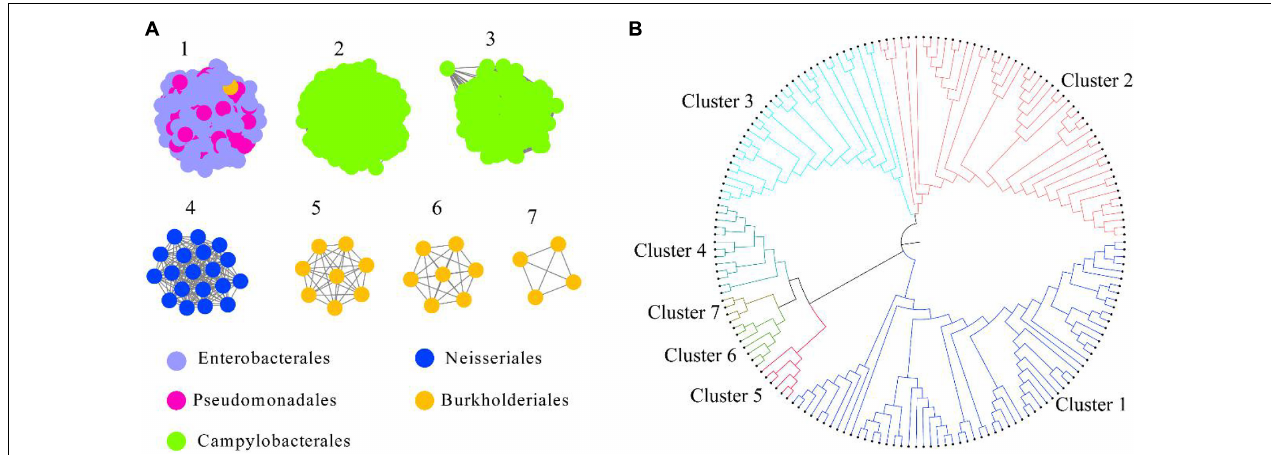
FIGURE 1 | Intestinal HepI clustering based on sequence similarity network and phylogenetic tree. (A) HepI from the human gut microbiome analyzed to create the network ( e -value < 10 − 3 , sequence identity > 45%). The results showed 1,613 nodes and one node represents one protein sequence. Nodes from the same order paint the same color in the network. (B) Evolutionary relationships of HepIs in different clusters. Maximum-likelihood phylogenetic tree for the selected HepIs from each clusters were generated using MEGA